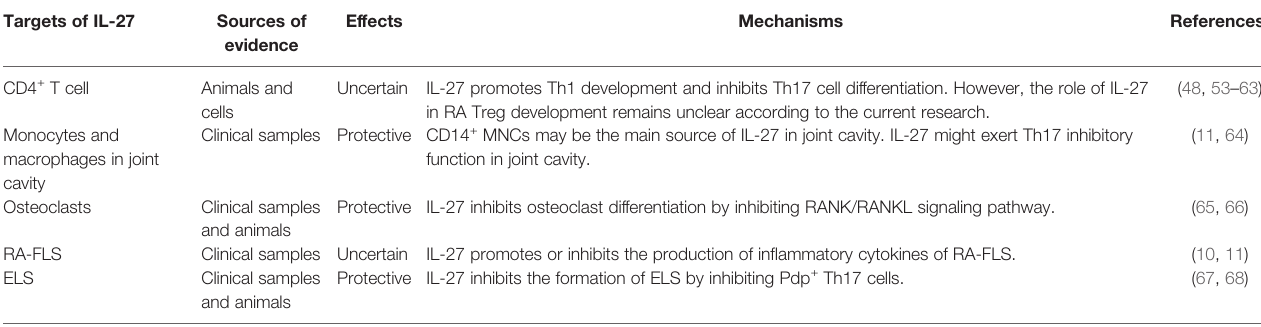
TABLE 1 | Effects and functions of IL-27 in RA different tissues and cells.